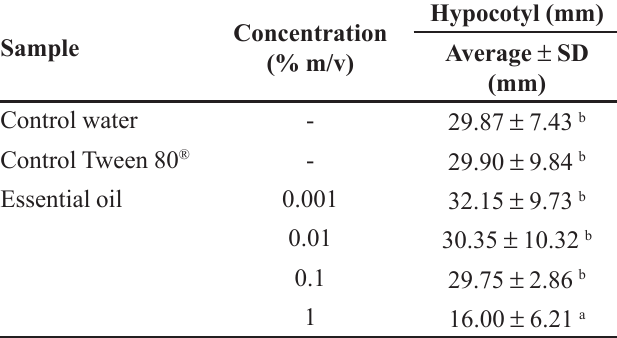
TABLE III - Results from the phytotoxicity in Lactuca sativa var.